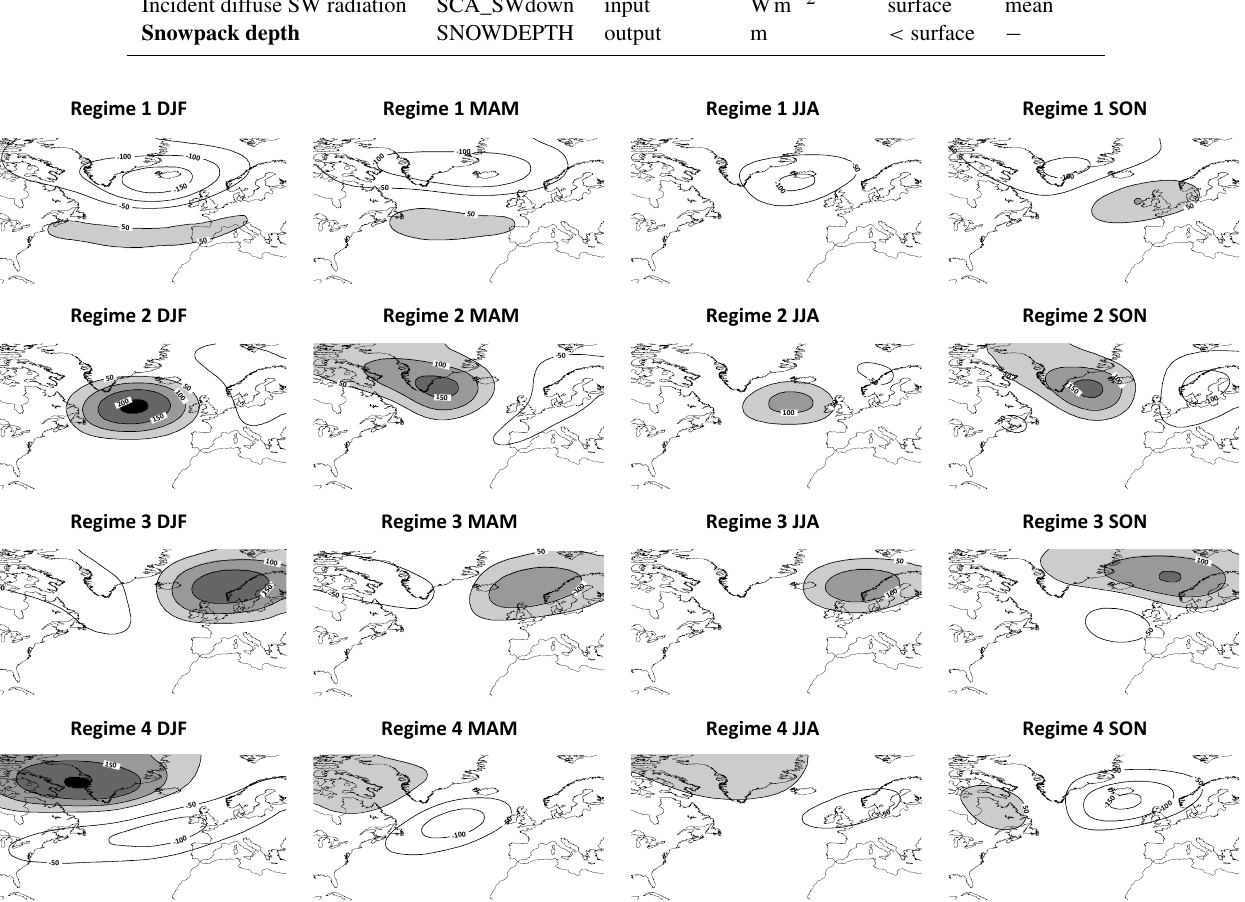
Figure 1. Clusters of each weather regime for the different seasons (winter: DJF, spring: MAM, summer: JJA, autumn: SON) used in this study: mean geopotential height at 500hPa (m) in ERA-40 over the period 1958–2001. The seasonal climatological mean was removed. Isohypses are represented every 50m and the zero isohypse is not represented. For readability, positive values are shaded progressively.